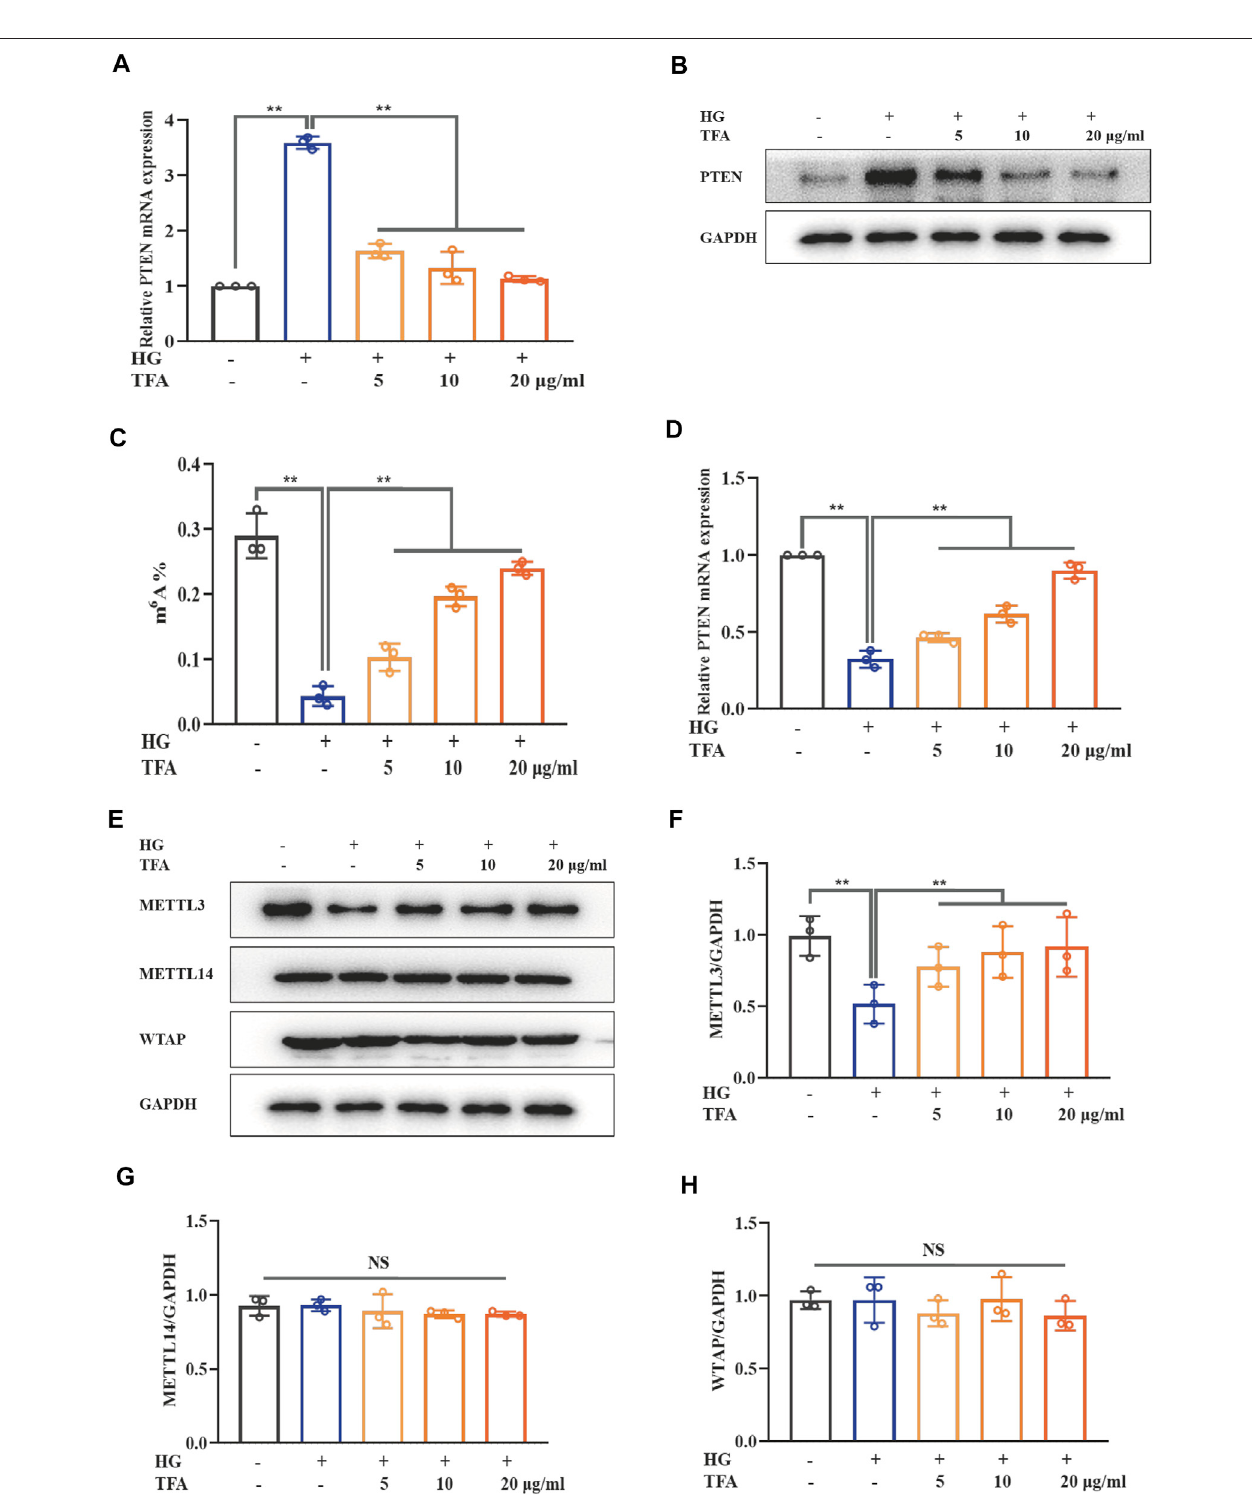
FIGURE7| TFAinhibitedPTEN/PI3K/Aktsignalingbyincreasingthem 6 Amodi fi cationofPTENmRNAinHG-af fl ictedMPC-5cells. (A) ThemRNAlevelsofPTENin cultured MPC-5 cells exposed to HG at 30 mM for 48 h with or without TFA at 5, 10, and 20 μ g/ml for 24 h by qRT-PCR; (B) WB analysis of PTEN in cultured MPC-5 cells exposed to HG at 30 mM for 48 h with or without TFA at 5, 10, and 20 μ g/ml for 24 h; (C) Quanti fi cation of m 6 A levels in cultured MPC-5 cells exposed to HG at 30 mM for 48 h with or without TFA at 5, 10, and 20 μ g/ml for 24 h by the m 6 A RNA methylation quanti fi cation kit; (D) The levels of methylated PTEN mRNA in the